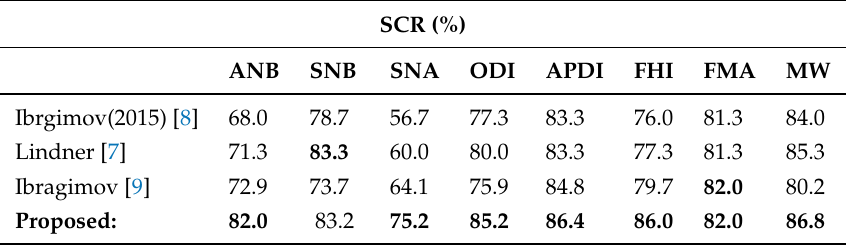
Table 7. Classification results for 8 measures, ANB, SNB, SNA, ODI, APDI, FHI, FMA and MW. We used junior doctors’ annotations as ground-truth